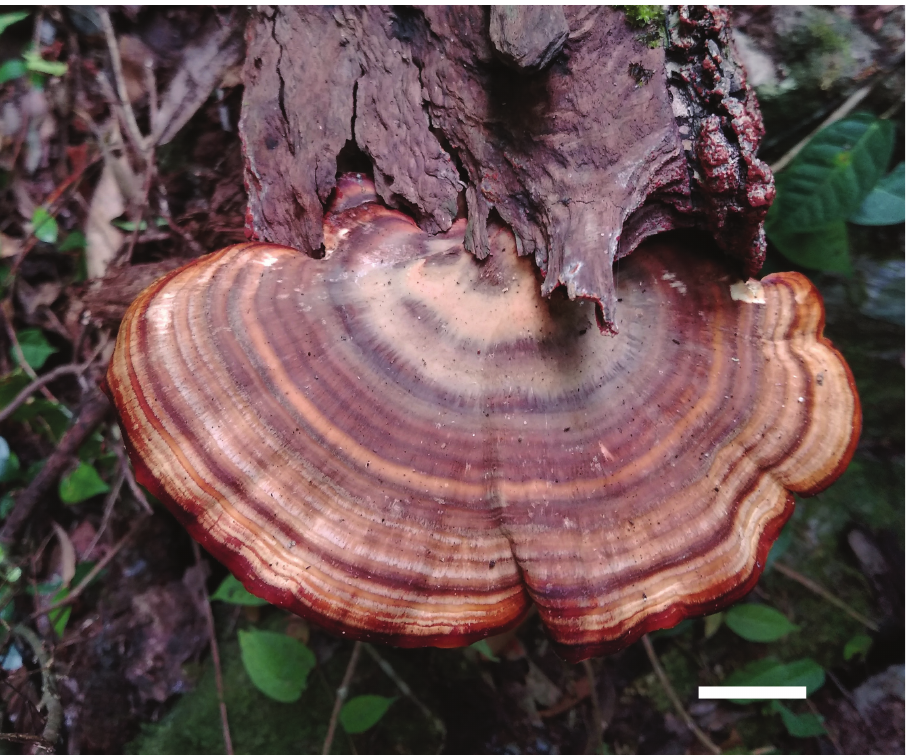
Figure 4. Basidiocarps of Trullella conifericola (IFP 019372, holotype). Scale bar: 10 mm.